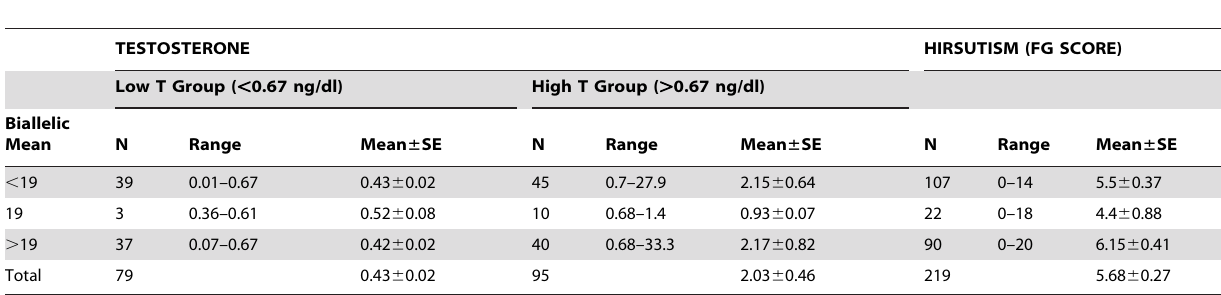
Table 6. Androgenic characteristics among PCOS cases under different biallelic mean